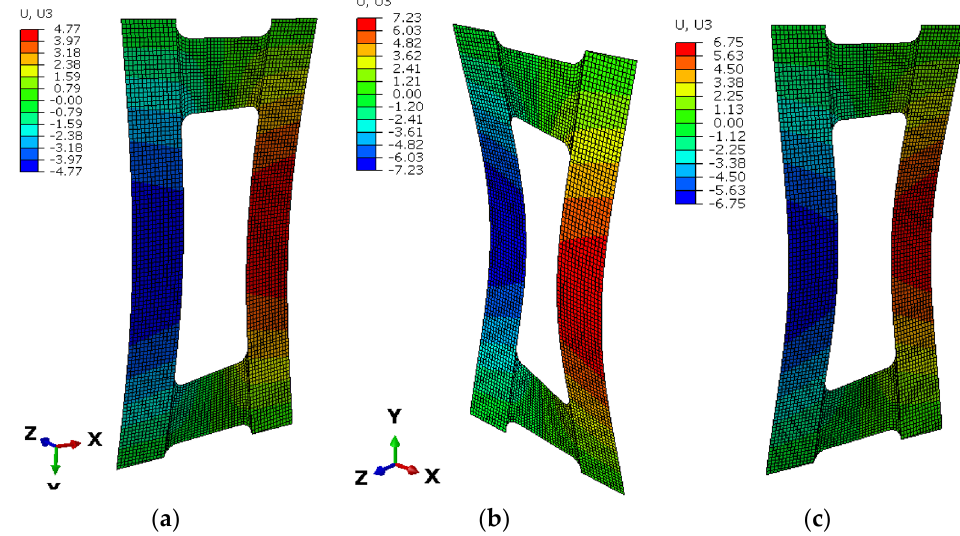
Figure 10. Numerical results of deflection for plate with angles ( a ) 30°, ( b ) 45°, and ( c ) 60°.